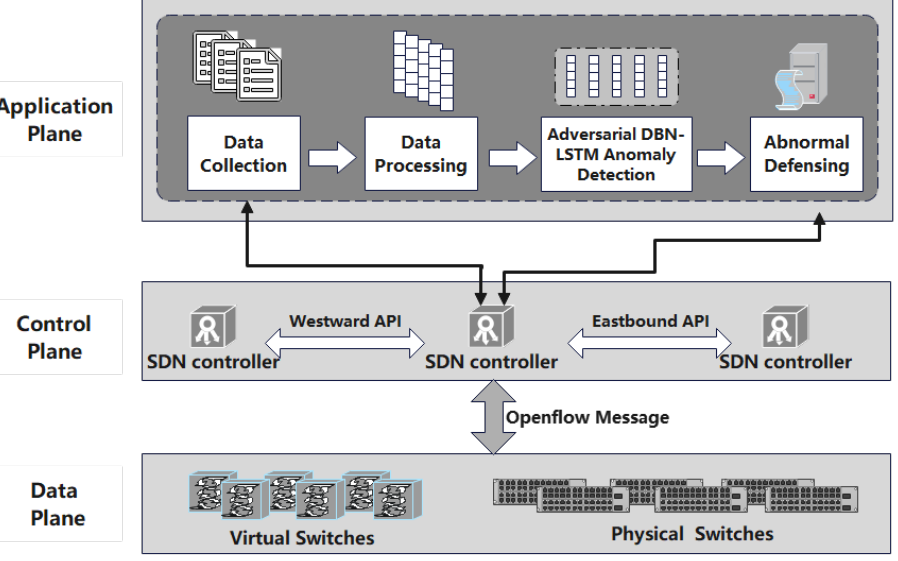
Figure 1. Proposed system architecture.